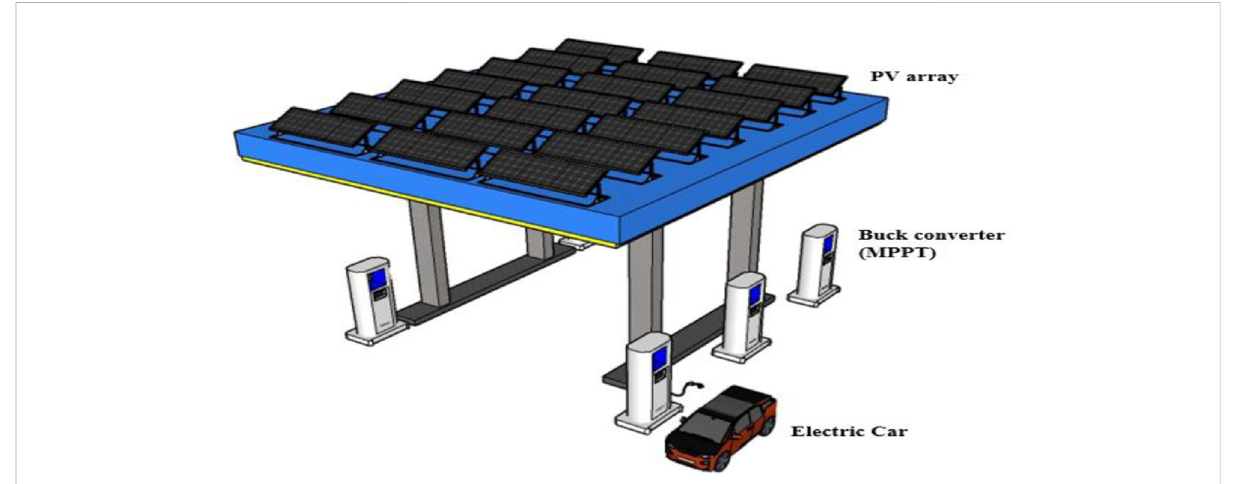
FIGURE 1 Main design of the EV charging station which is powered by the PV